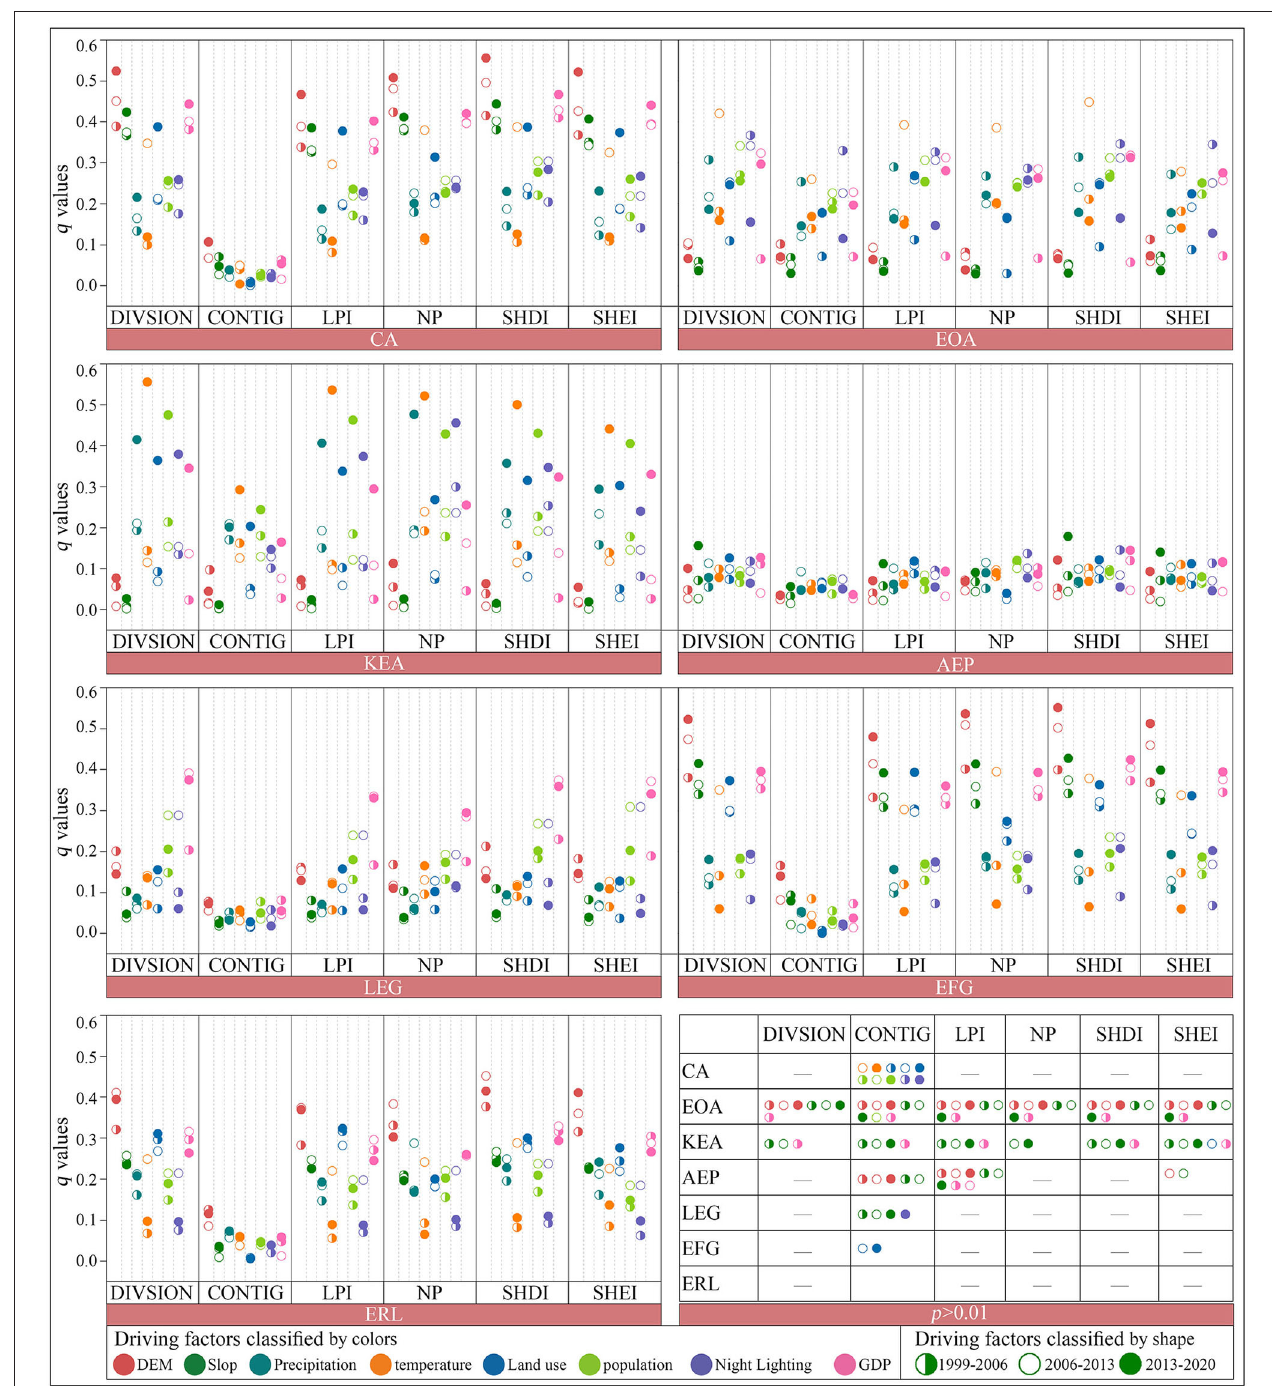
FIGURE 7 | The q and p -values of driving factors in the county scale and environmental functional regions. q represents the determinant power and p represents the correlation coefficient.